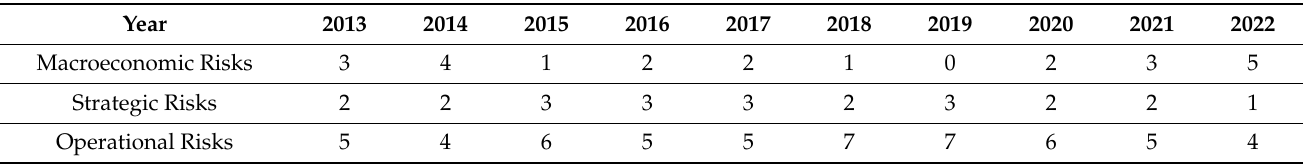
Table 9. Type of Risk Identified as a Top Ten Risk in Survey Year.